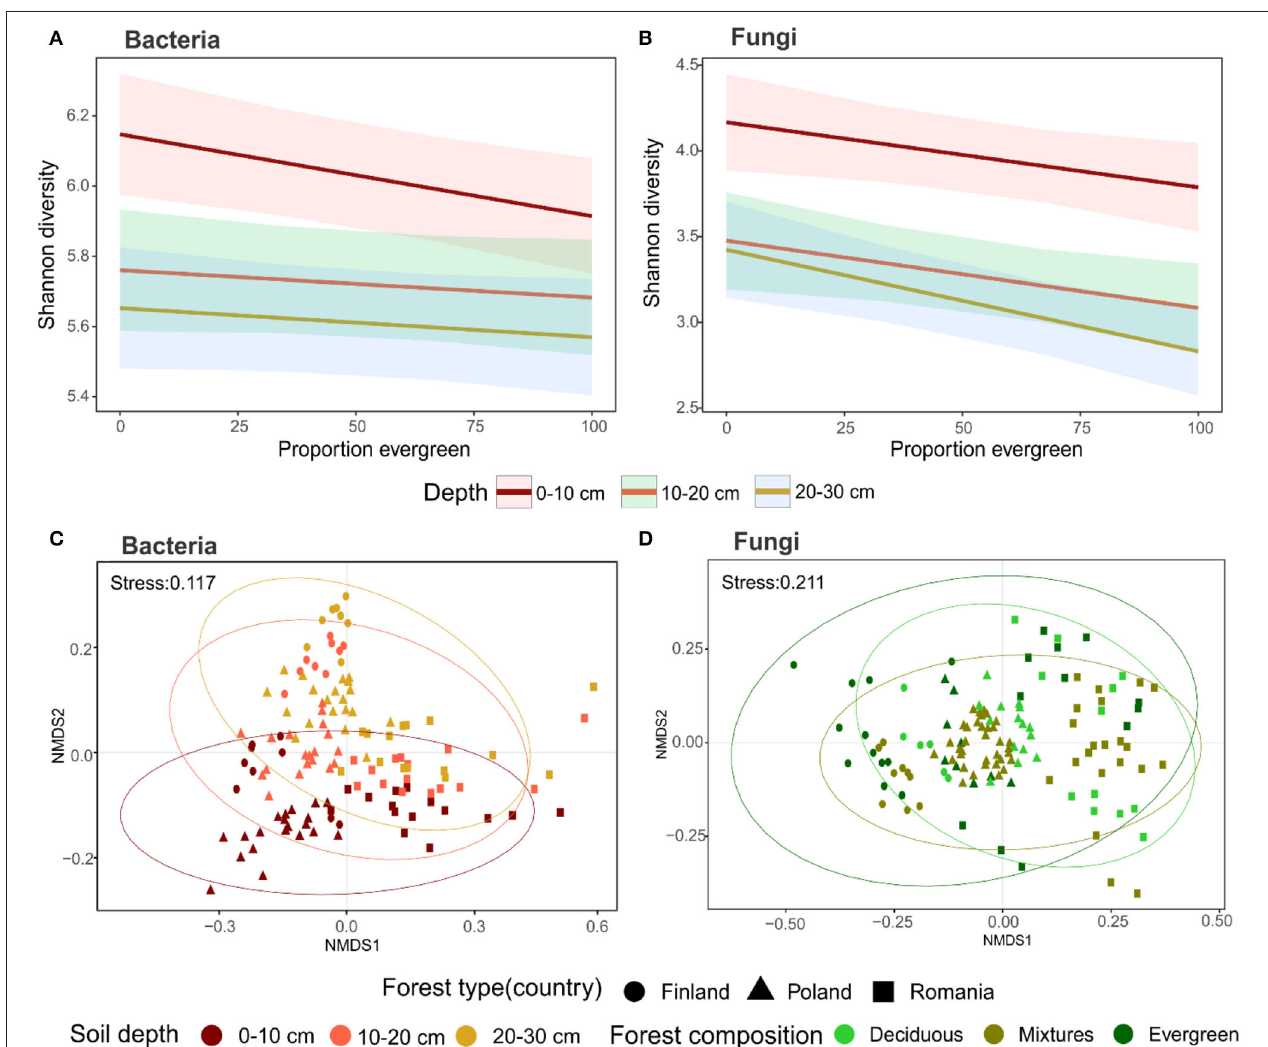
FIGURE 2 | Diversity and community composition associated with forest compositions and soil depth: (A) Bacterial and (B) Fungal Shannon diversity in relation to evergreen proportions, lines represents linear model estimates and shaded areas represent 95% confidence; (C) Bacterial and (D) Fungal community composition depicted as NMDS scaling based on Bray-Curtis dissimilarity, and different colors represent the strongest impacting variables according to PERMANOVA (for statistical details see Supplementary Tables 5 , 6 ).